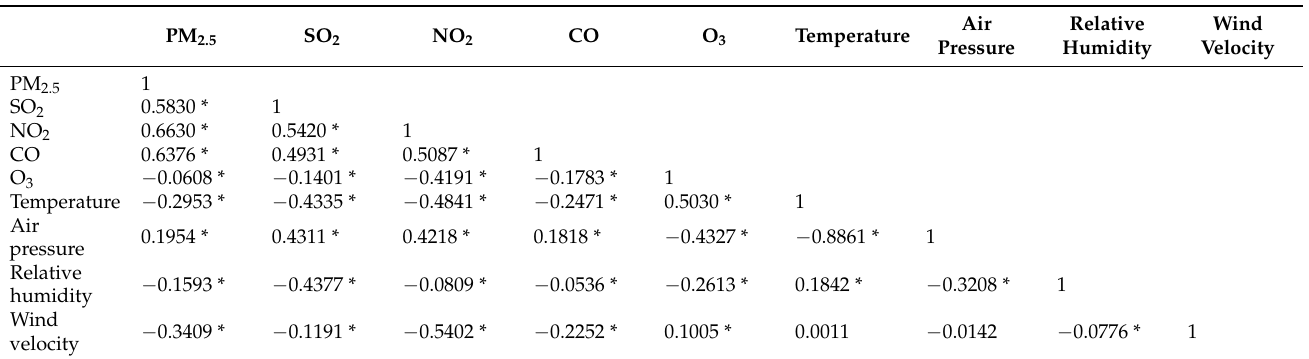
Table 2. Results of correlation analysis between air pollutants and meteorological factors in Xuhui District, Shanghai, 2014–2019.